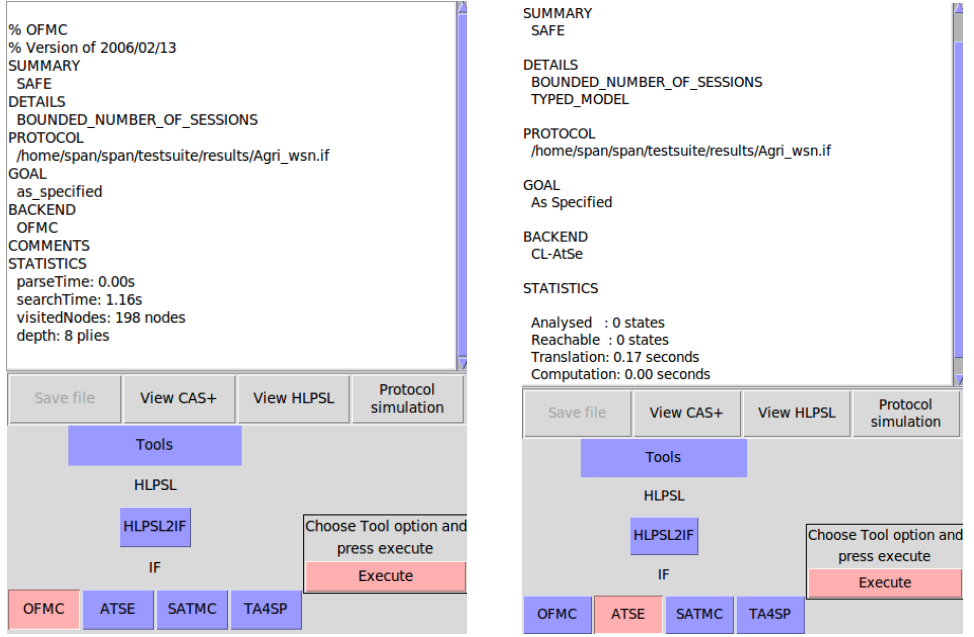
Figure 16. The simulation results using OFMC and CL-AtS back-ends in Case